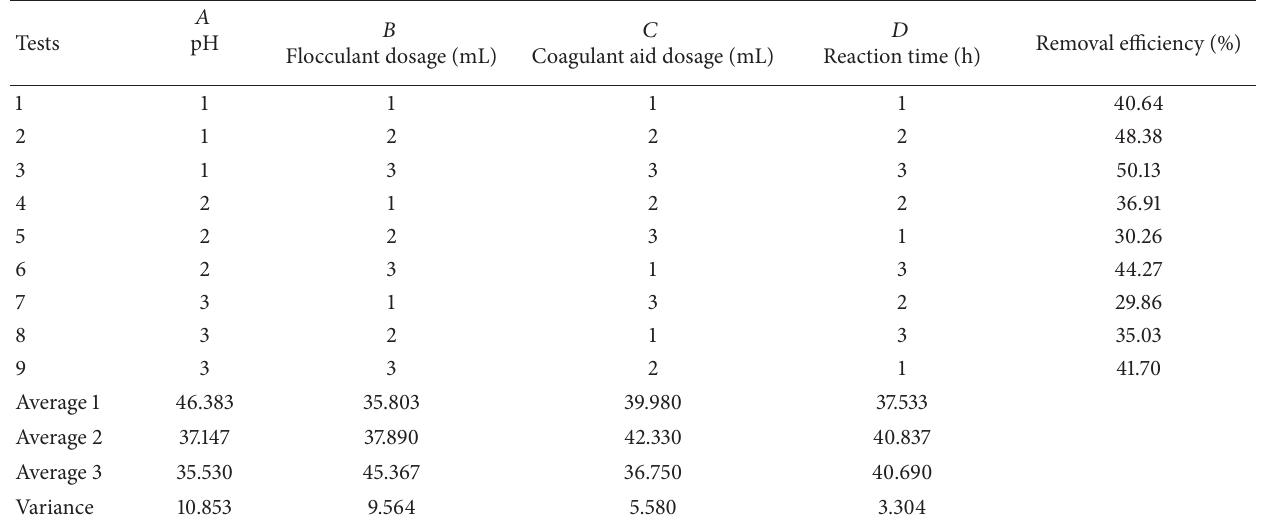
Table 4: Orthogonal test result and visual analysis.